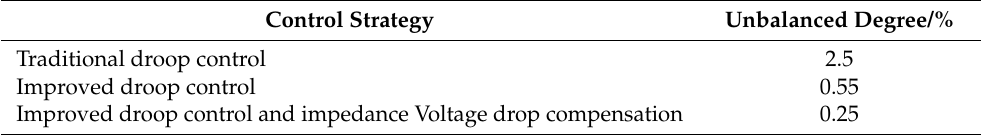
Table 2. Unbalanced degree of three-phase voltage for three strategies with unbalanced